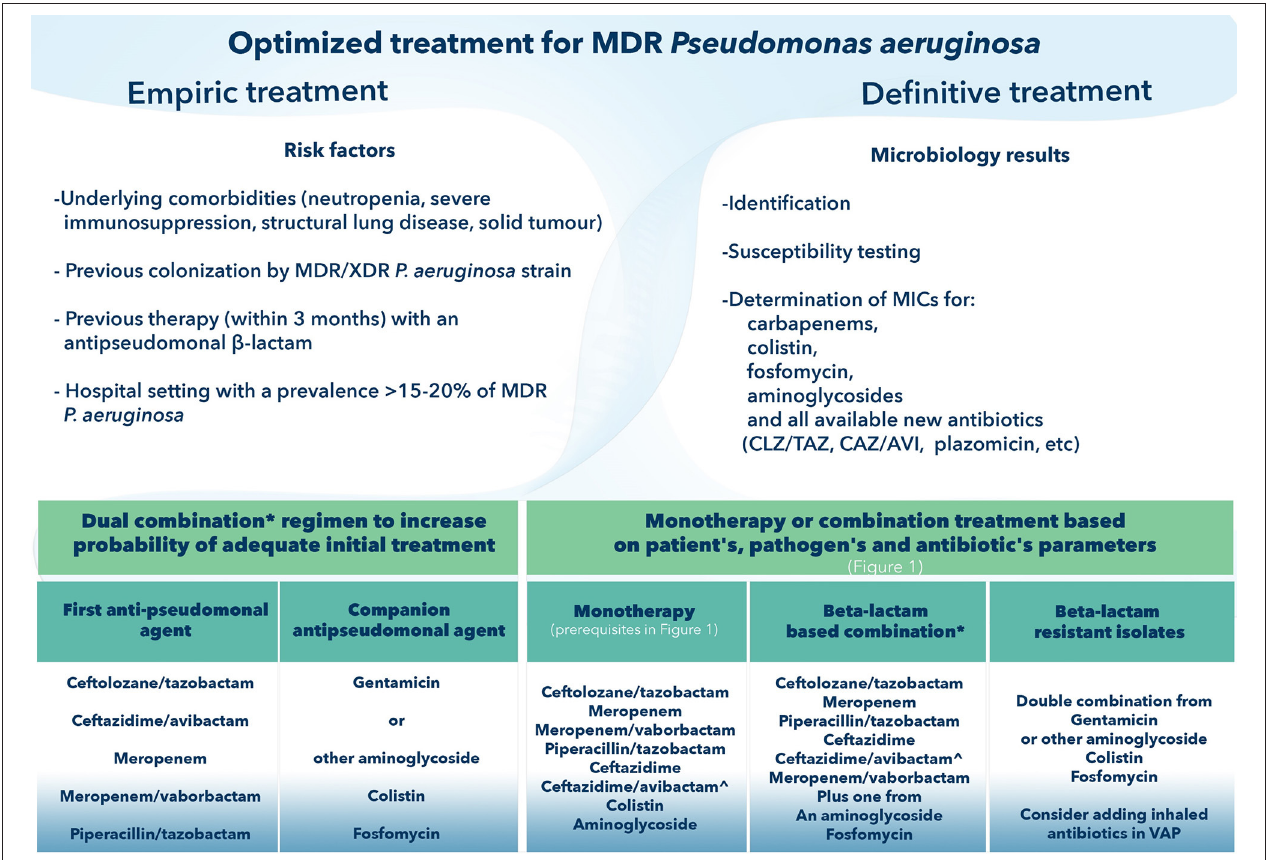
FIGURE 3 | How to optimize treatment of Multi-drug-resistant Pseudomonas aeruginosa. CAZ-AVI, ceftazidime avibactam; CLZ/TAZ, ceftolozane tazobactam; MDR, Multi-drug resistant; MIC, minimum inhibitory concentration; XDR, extensively drug-resistant; VAP, ventilator-associated pneumonia. *Components of the combination will be based on: (i) epidemiology data (for empirical regimen); (ii) pharmacokinetic/pharmacodynamic considerations relating to the source of infection; (iii) lower MIC (if possible, avoidance of antibiotics with borderline susceptibility). ∧ Selection of CAZ-AVI in definitive treatment precludes demonstrated in vitro susceptibility and absence of detected metallo-beta lactamase mechanism of